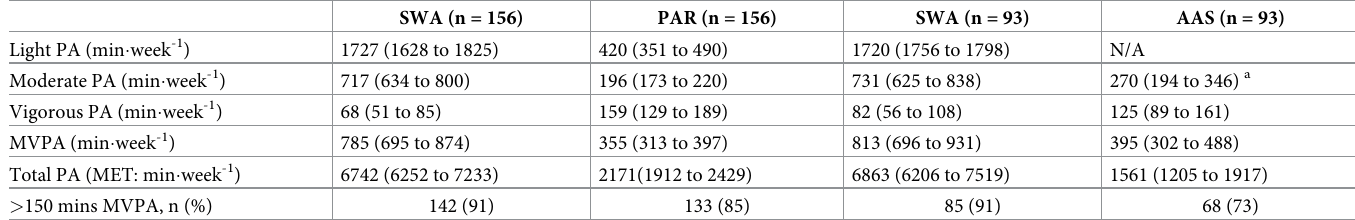
Table 1. Weekly totals as assessed by the SWA, the PAR, and the AAS for the study sample. Data are mean and 95% CI. SWA (n =